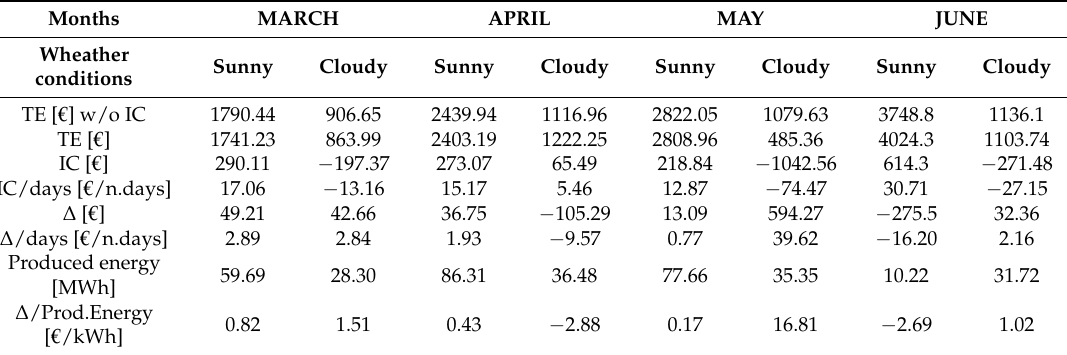
Table 5. Example of imbalance data and payments for a typical March day.